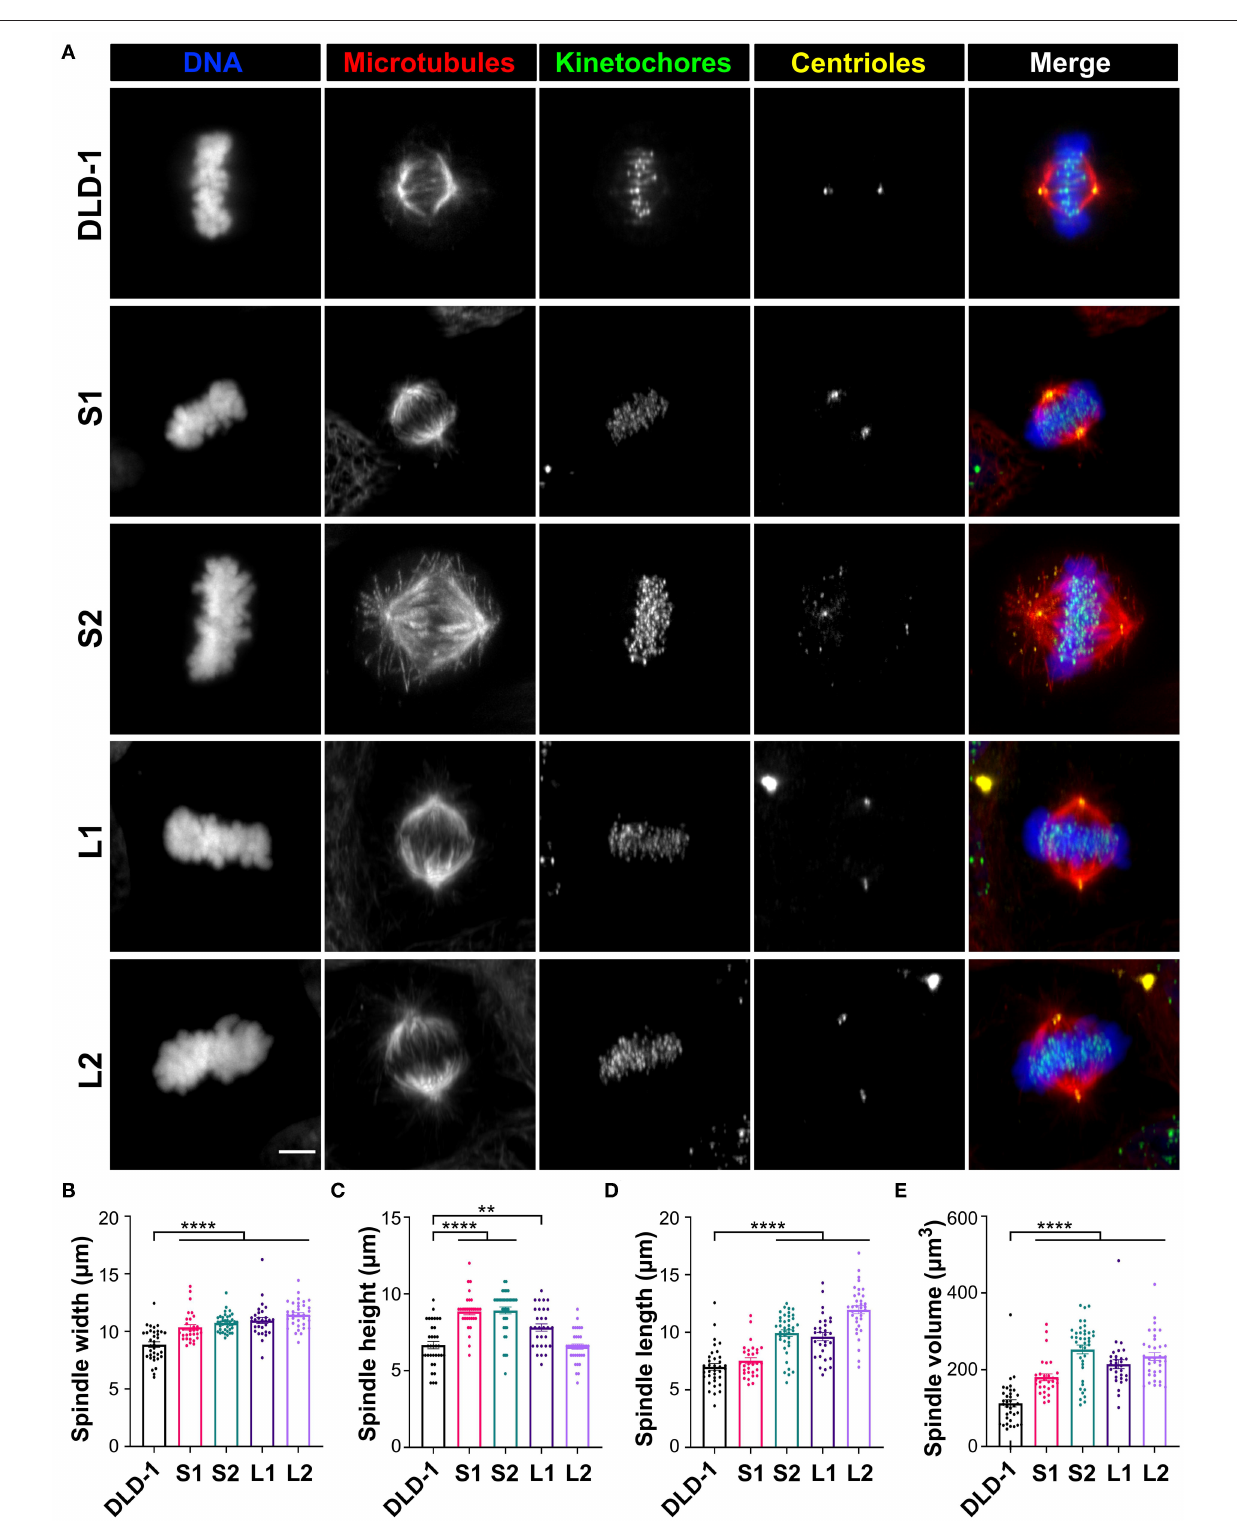
35, 30, 40, 30, and 35, respectively). ** p < 0.01, =